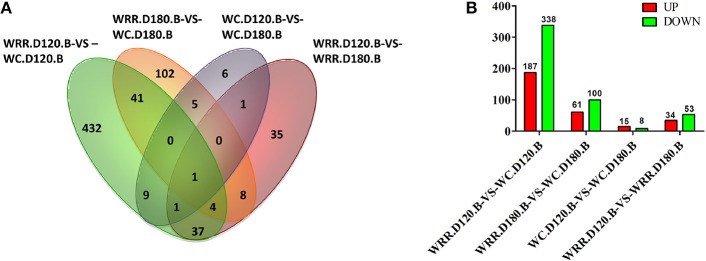
Differentially expressed genes among four comparisons. (A) Differentially expressed genes that are unique or shared among four comparisons. (B) Differentially expressed genes that are up-regulated expression (red) or down-regulated expression (green) in the latter of each contrast. WC, Wenchang chicken; WRR, White Recessive Rock chicken; B, breast muscle.